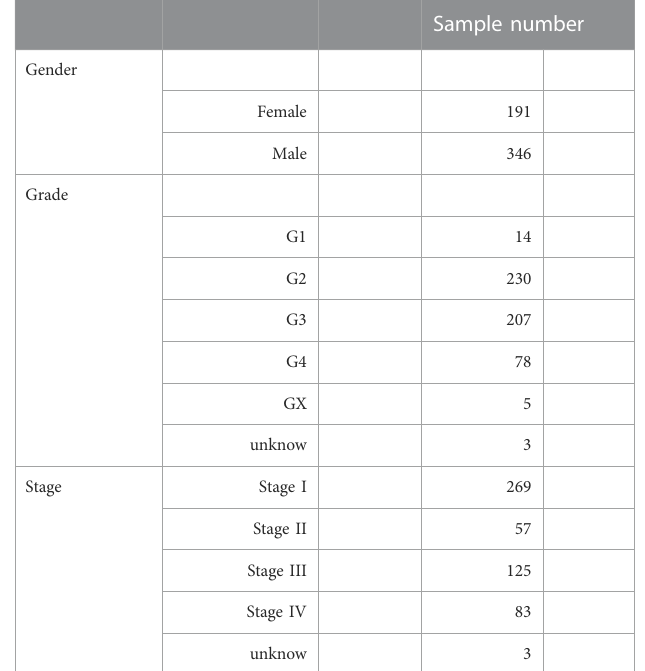
TABLE 1 Clinical data clinical correlation analysis of survival related genes of